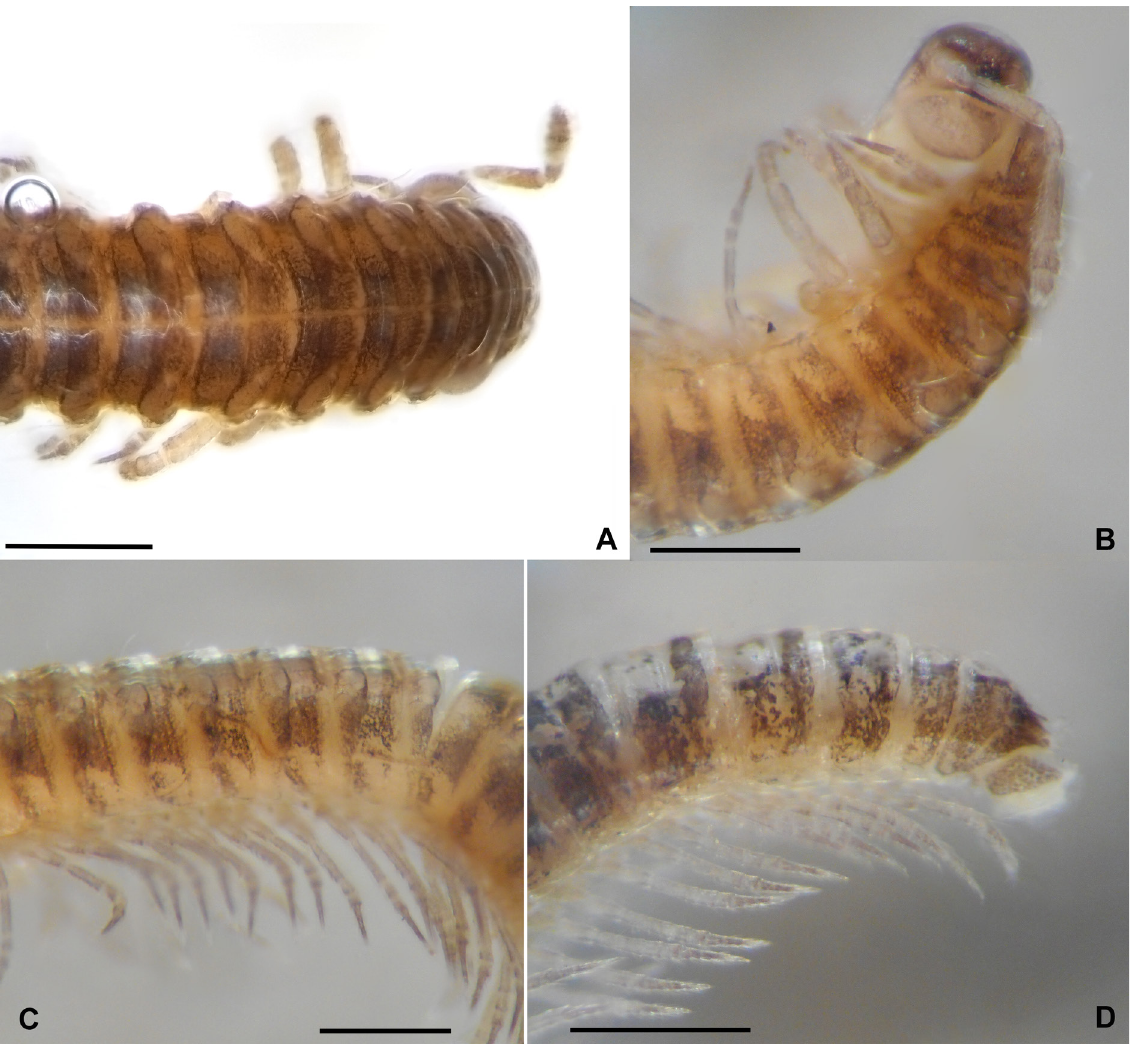
Fig. 1. External habitus of Anamastigona cypria sp. nov., ♂, paratype from Nicosia, Pediaios. A . Anterior part of body, dorsal view. B . Anterior part of body, lateral view. C . Middle part of body, lateral view. D . Posterior part of body, lateral view. Scale bars = 0.5